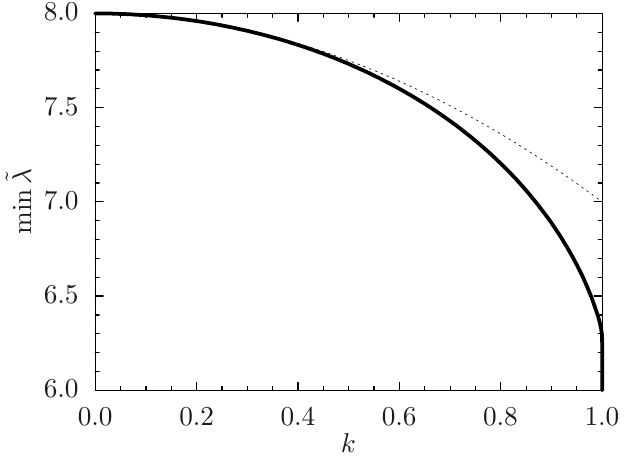
Figure 5 . The smallest eigenvalue (ground state) of the operator ~(cid:1), de(cid:12)ned by eq. (4.24), as a function of k . The dashed line indicates the asymptotic behavior for small k given by eq.